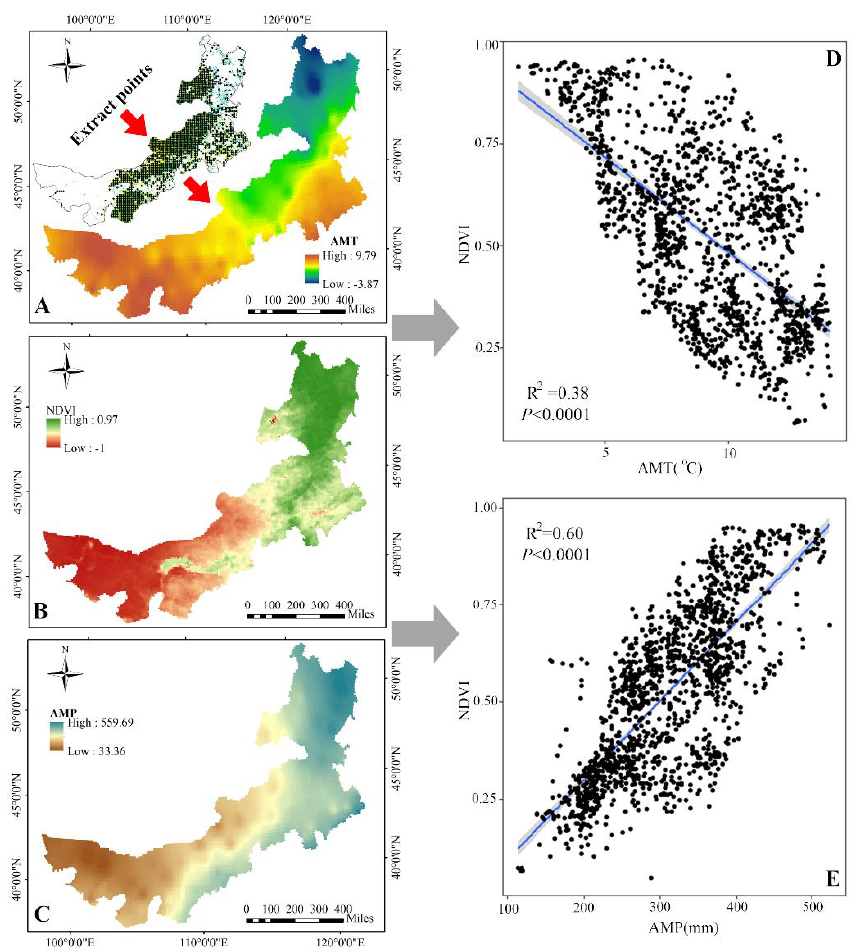
Figure 2. Spatial patterns of AMT ( A ), NDVI ( B ), AMP ( C ), and correlation between NDVI and temperature ( D ) and precipitation ( E ) in 1982. AMT, AMP, and NDVI represent the annual mean temperature, annual mean precipitation, and the normalized difference vegetation index, respectively.